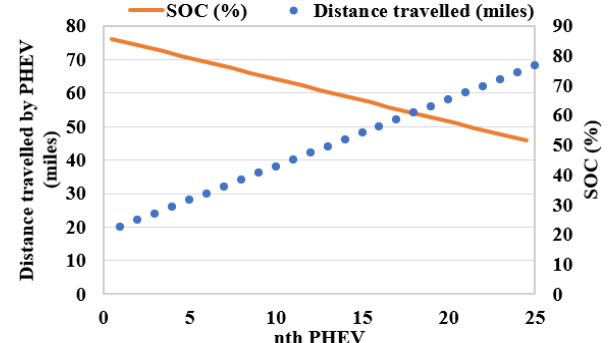
Fig.6. Relationship between